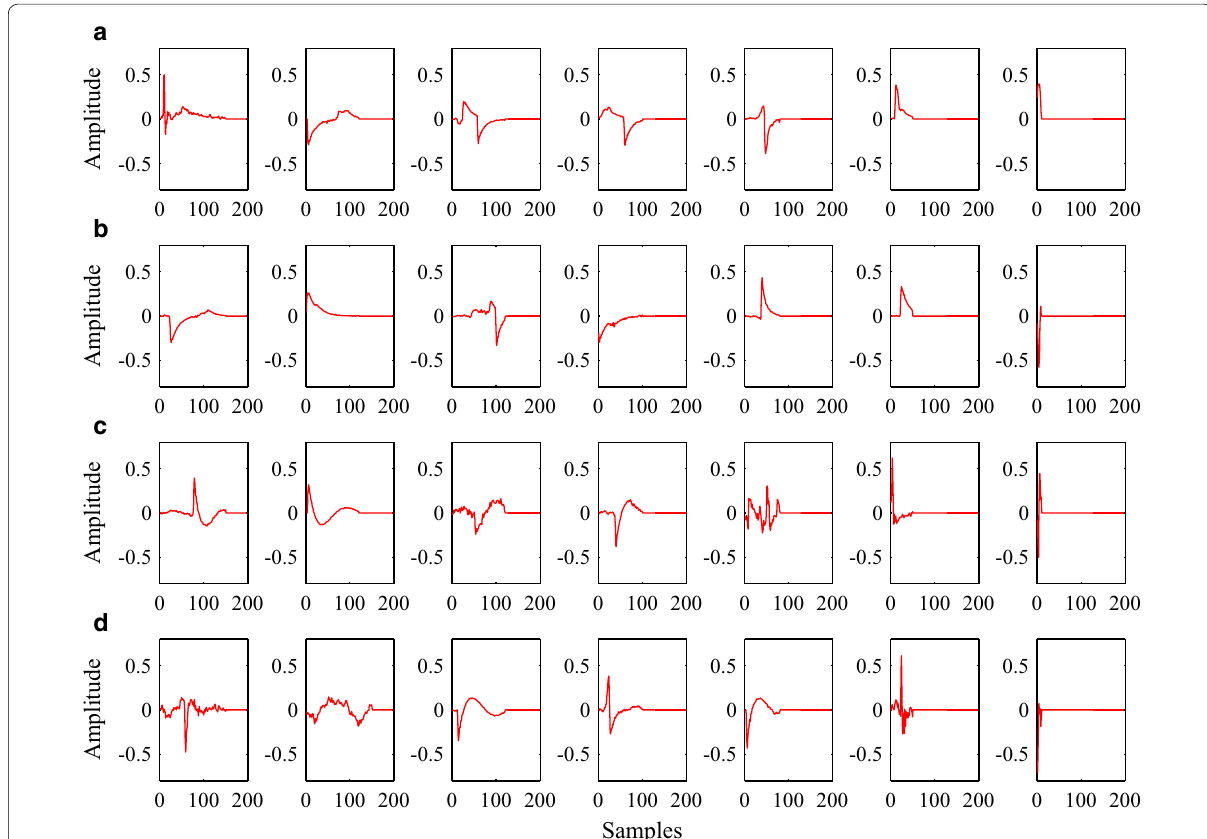
Fig. 10 Feature structures (atoms) learned from Ex ( a ), Ey ( b ), Hx ( c ) and Hy ( d ) components of the MT data set EL22192 (a sampling rate of 150 Hz) using